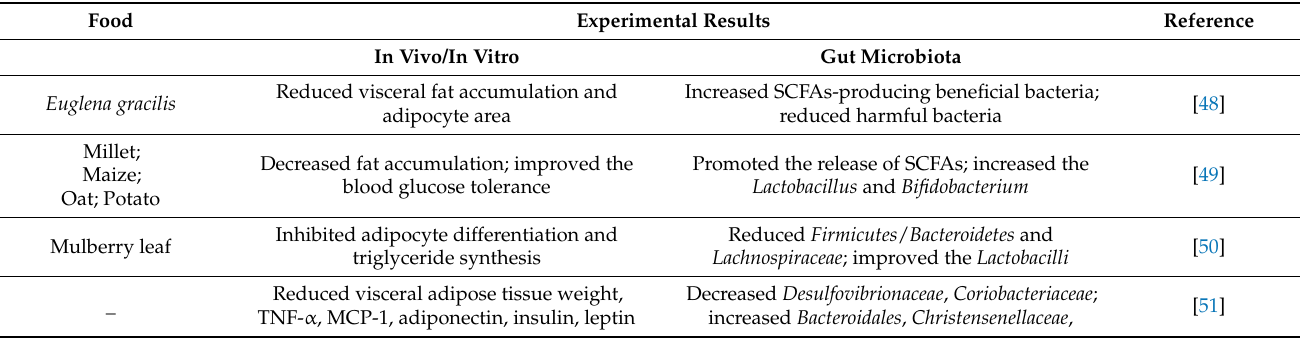
Table 2. Combined different food or compounds against obesity in vitro/in vivo based on gut microbiota. Experimental